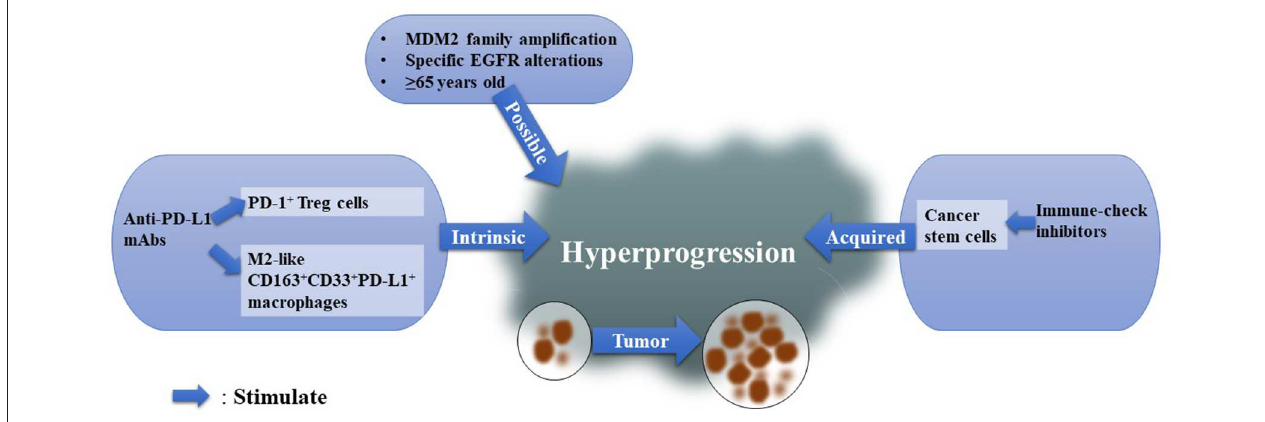
FIGURE 2 | Possible Mechanisms for HPD. We summarized existing mechanisms for HPD and classified them into three types: intrinsic immunological reasons, acquired elements, and possible factors.